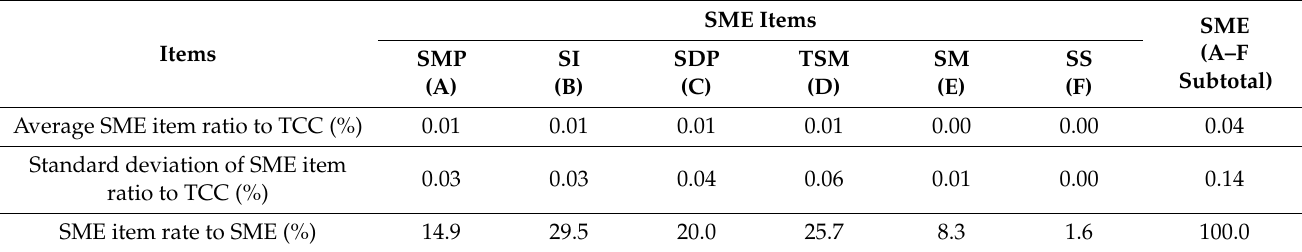
Table 10. Ratio analysis of SME items to TCC.